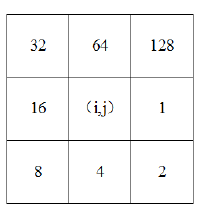
Figure 2. The direction of D8 algorithm